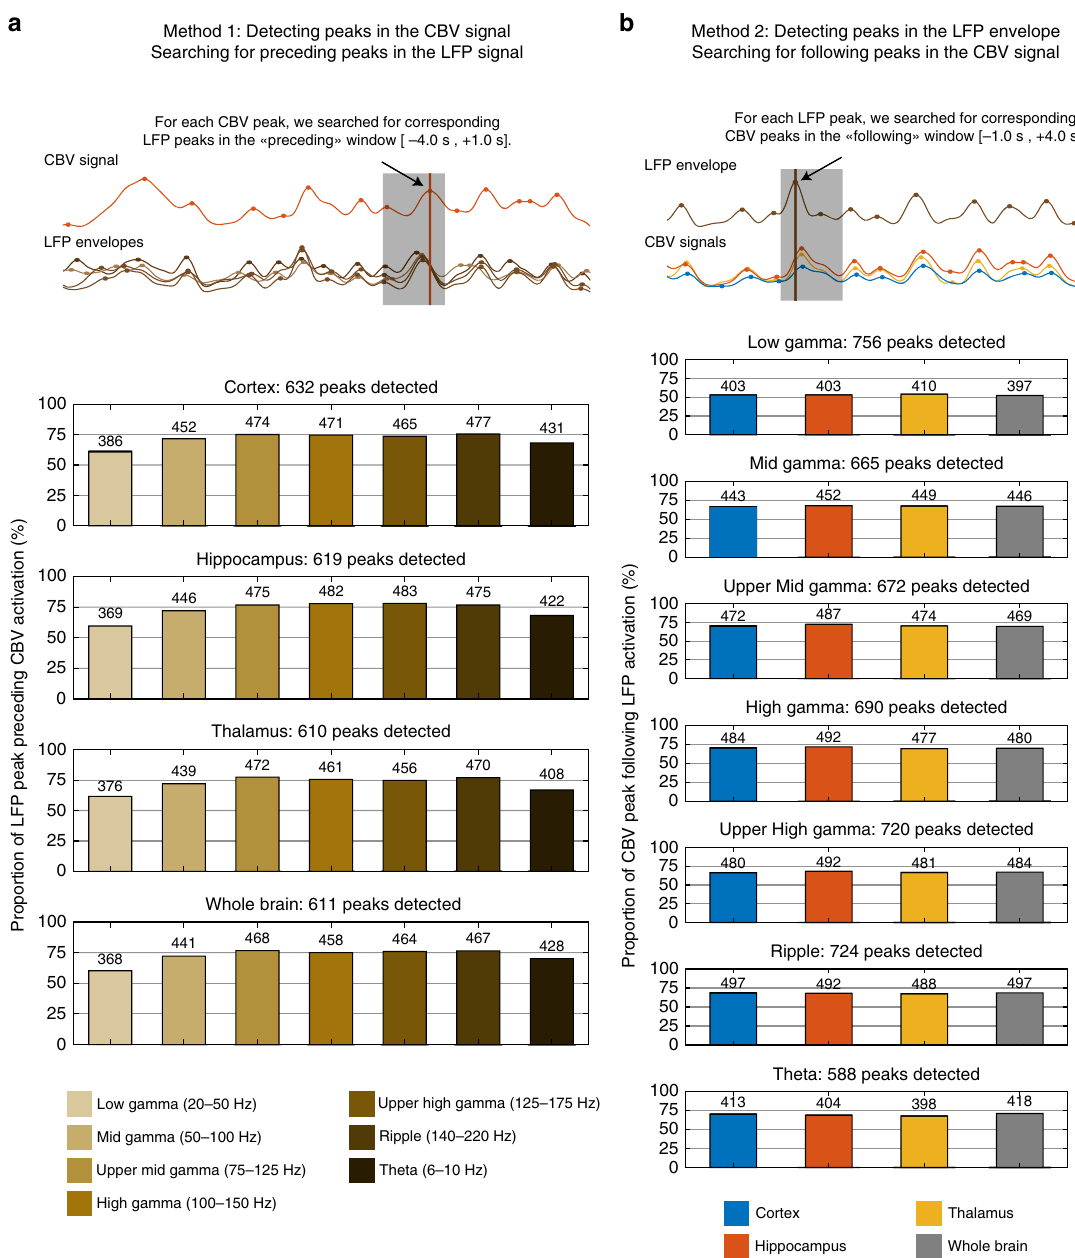
Fig. 4 Co-occurrence analysis of LFP and CBV activation peaks. a We fi rst detected peaks for each of the four regional CBV averages (cortex, hippocampus, thalamus, and whole). For each detected peak, we searched for peaks in the seven LFP envelope signals (Low-Gamma, Mid-Gamma, Upper Mid-Gamma, High-Gamma, Upper High-Gamma, Ripple, and Theta) in the timing window [ − 4.0 s, + 1.0 s] preceding the CBV peak. If more than one peak was found, the closest was selected. The bar graphs display the proportion of LFP peaks found for each LFP-CBV signal pair (absolute number are given on top of each bar). For all regions, the highest LFP-CBV co-occurrence ratio is found in the high-gamma band. b We performed the complementary approach by detecting LFP peaks and searching the timing window [ − 1.0 s, + 4.0 s] following LFP peak. The highest LFP-CBV co-occurrence ratio is found in the hippocampus no matter the LFP band. Analysis performed for n = 7 animals overs 28 recordings. The corresponding LFP-CBV correlations and delay histograms are shown in the following Supplementary Figs. 5 and